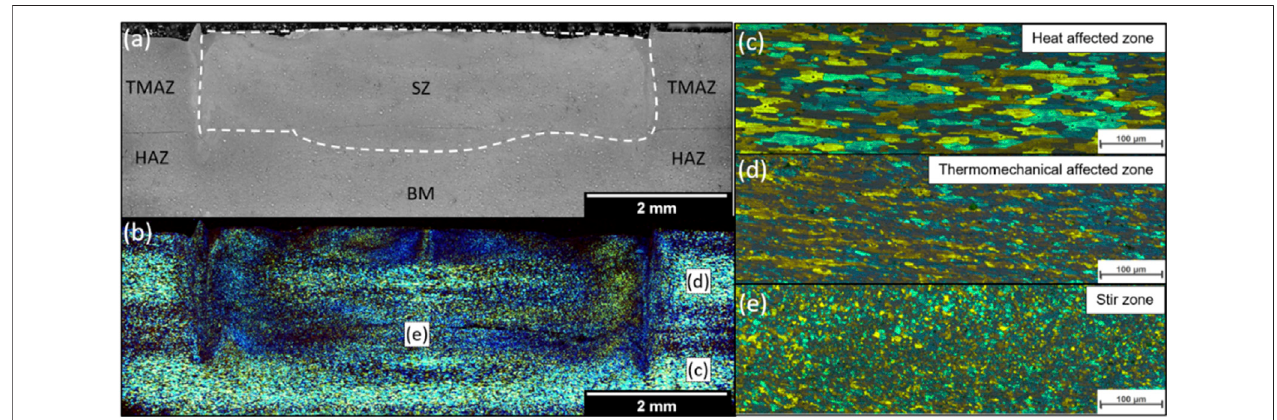
FIGURE 6 | Light optical microscopy image of the Trial I joint in (A) bright fi eld, (B) polarized light after the electrolytic etching, (C) heat affected zone, (D) thermomechanicalaffectedzone,and (E) stirzone.Thelastthreeareindicatedin (B) .SZstandsforstirzone,TMAZthermomechanicalaffectedzone,HAZheataffected zone and BM base material. The white dashed line delimits the processing